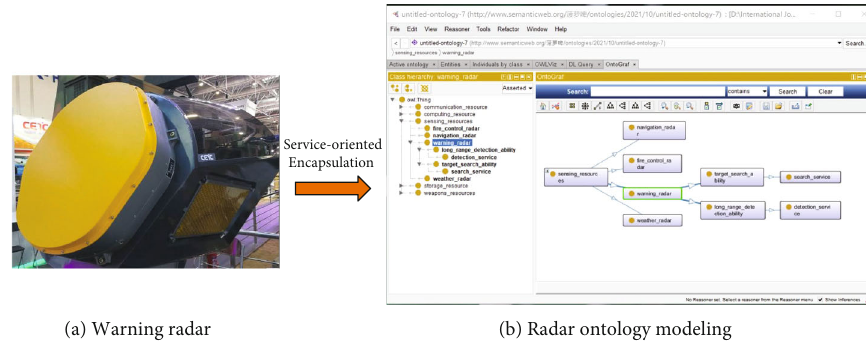
Figure 5: Radar ontology modelling. Table 2: Task requirement information